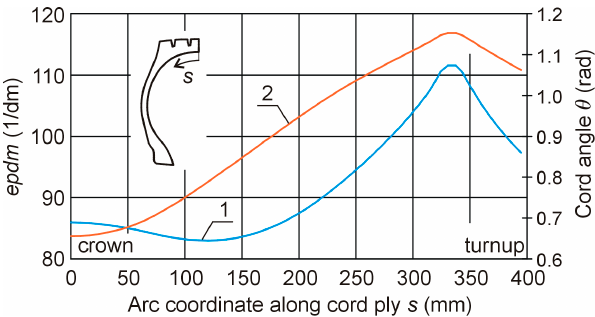
Figure 3. Cord parameter variations along body ply in a bias tire; 1 – cord ends per decimeter ( epdm ), 2 – cord angle θ .